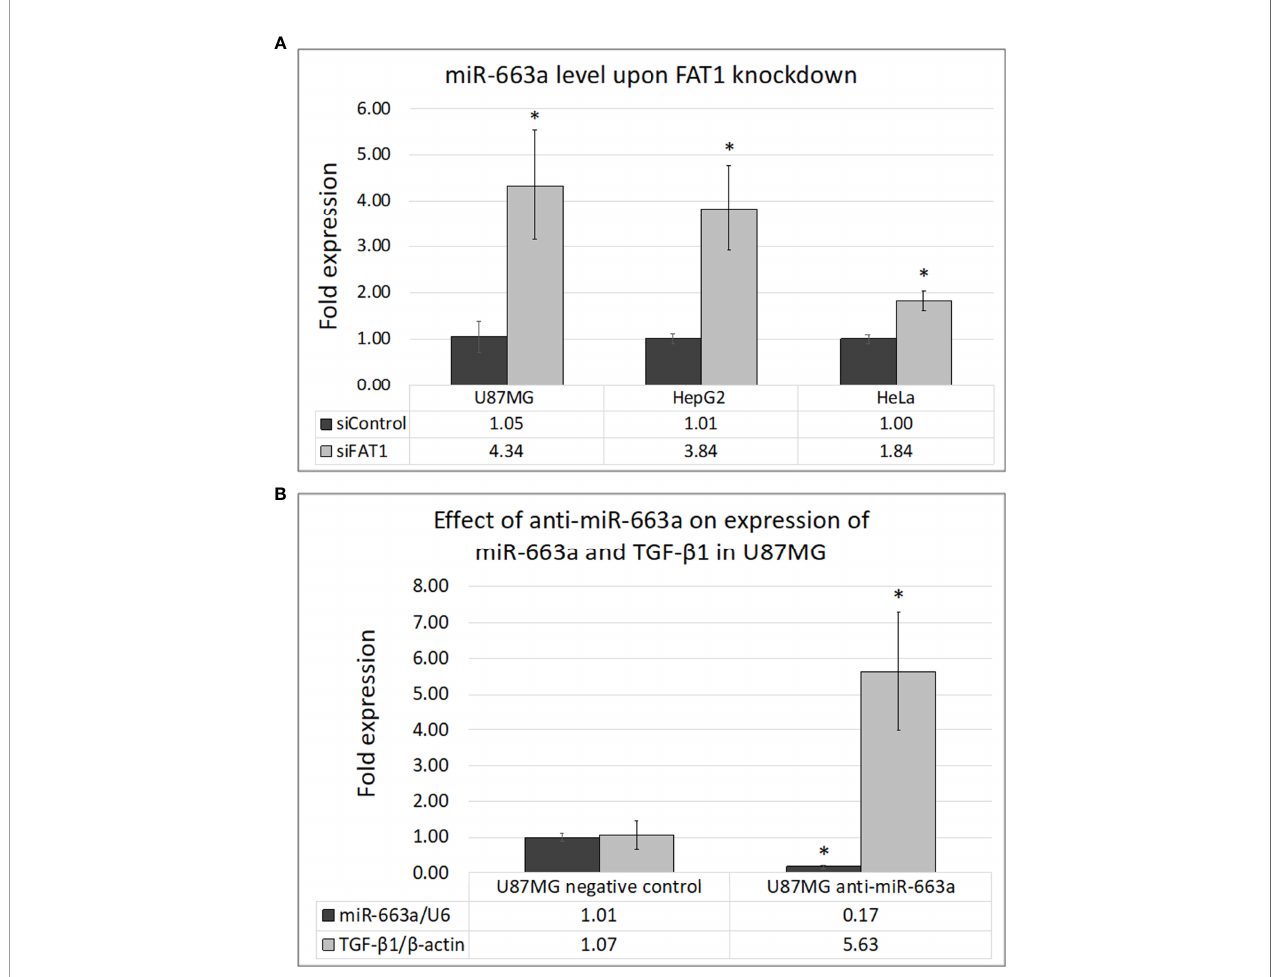
FIGURE 5 | (A) Effect of FAT1 knockdown on the expression of miR-663a in U87MG, HepG2, and HeLa cells as assessed by q-PCR. (B) Inhibition of miR-663a in U87MG cells and its effect on the expression of TGF- b 1 as assessed by q-PCR. miR-663a expression has been normalized relative to U6 internal control reference, while TGF- b 1 expression has been normalized relative to b -actin internal control reference. (*) indicates p-value ≤